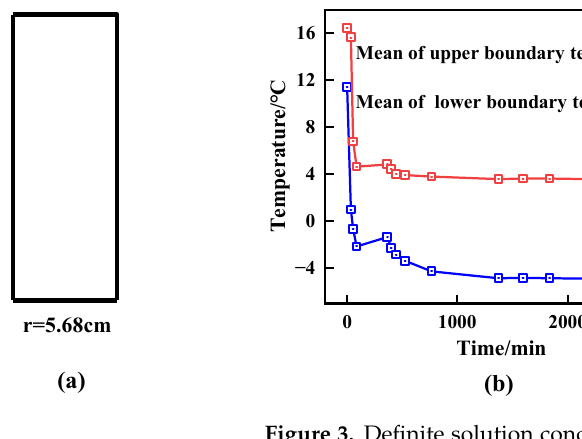
Figure 3. Definite solution conditions. ( a ) Geometric conditions; ( b ) boundary conditions; ( c ) initial conditions.